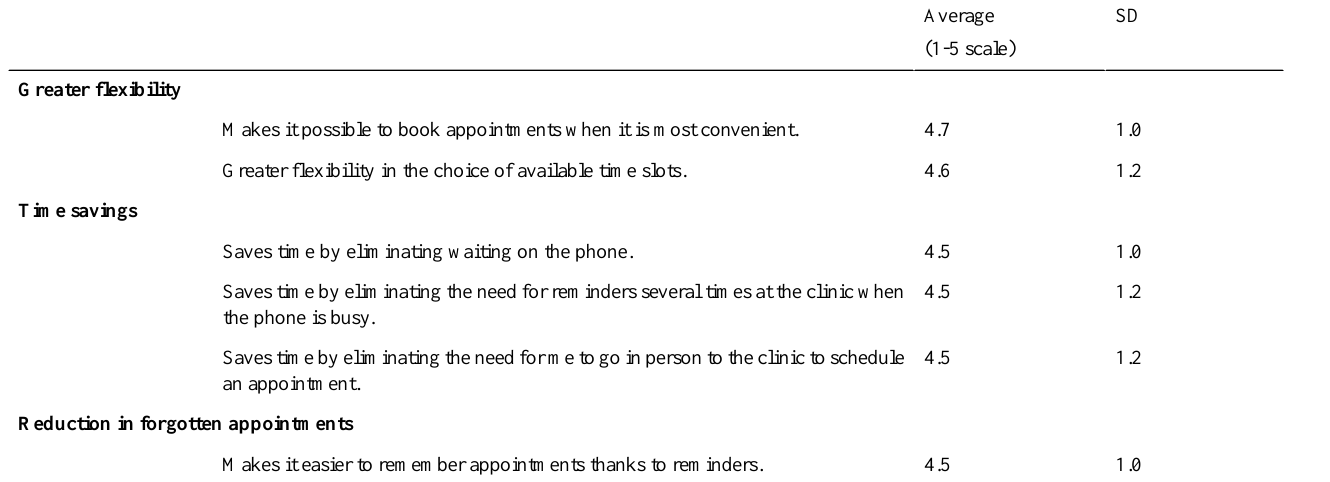
Table 4. Perceived benefits of using the e-booking system (n=241).